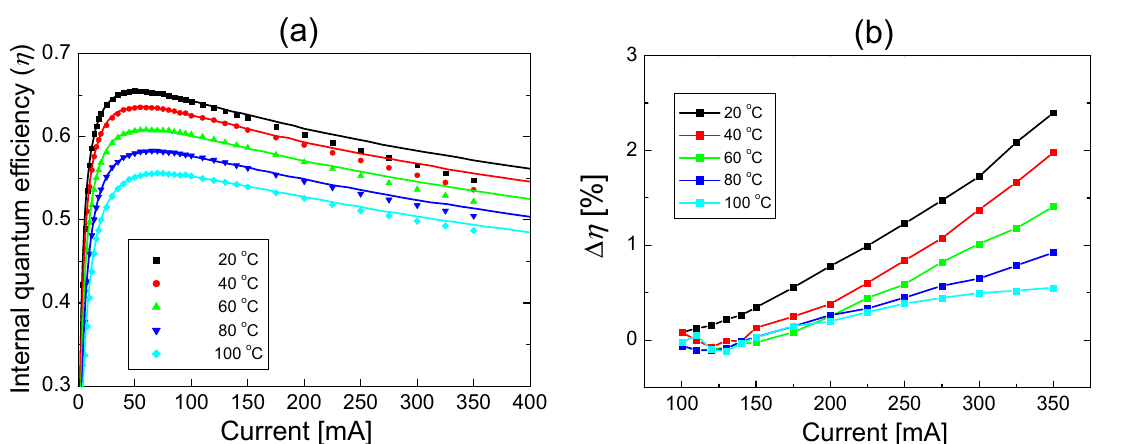
Figure 2. ( a ) Theoretical fit (lines) of the internal quantum efficiency (IQE) using ABC model without carrier leakage to the measured EQE data (solid dots) at temperatures of 20, 40, 60, 80, and 100 °C. ( b ) Difference in IQE ( ∆ η ) between the fit curve and the measured data at temperatures of 20, 40, 60, 80, and 100 °C when injection current is greater than 100 mA.